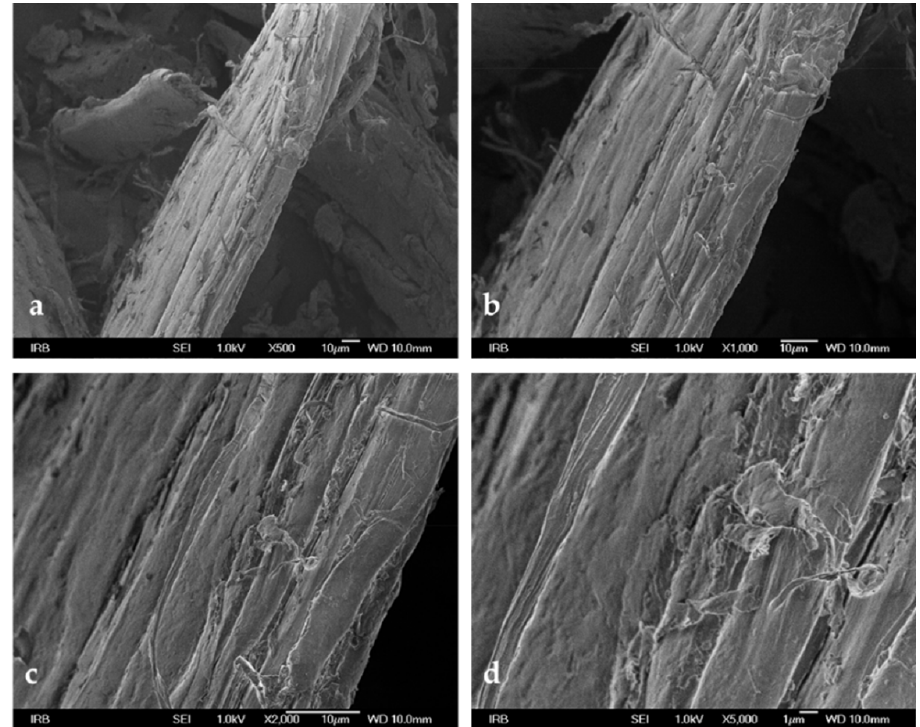
Figure 3. Field emission scanning electron microscopy (FE-SEM) micrographs of Euroamerican poplar (EP) at different magnifications: ( a ) 500, ( b ) 1000, ( c ) 2000, ( d ) 5000.